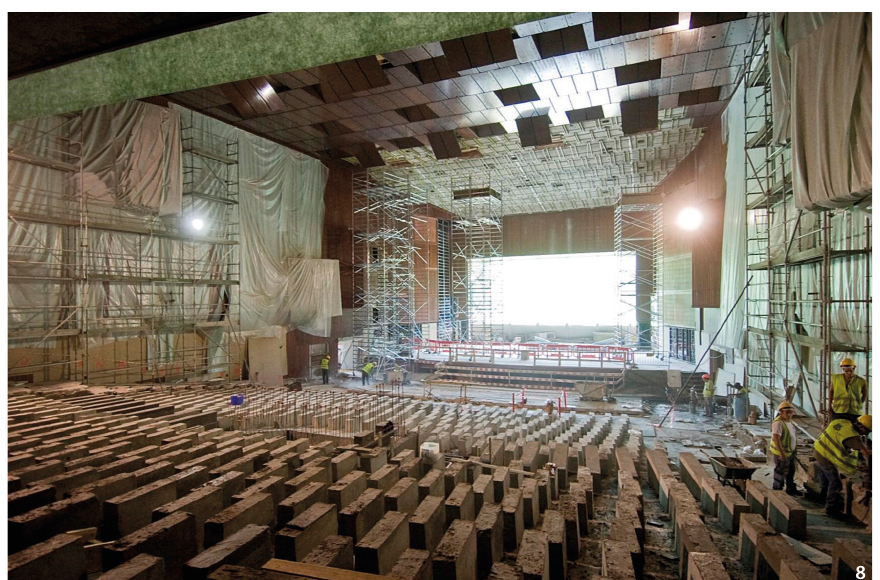
Figure 8 Alberto Pessoa, Pedro Cid, Rui Athouguia, Calouste Gulbenkian Foun- dation, Lisbon, Portugal, 1969. Renova- tion of the Auditorium, 2013 (Source: Márcia